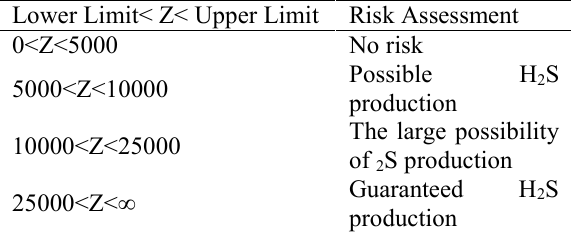
Table 1. Risk of H 2 S Production in Gravity Sewers Based on Z Formula Lower Limit< Z< Upper